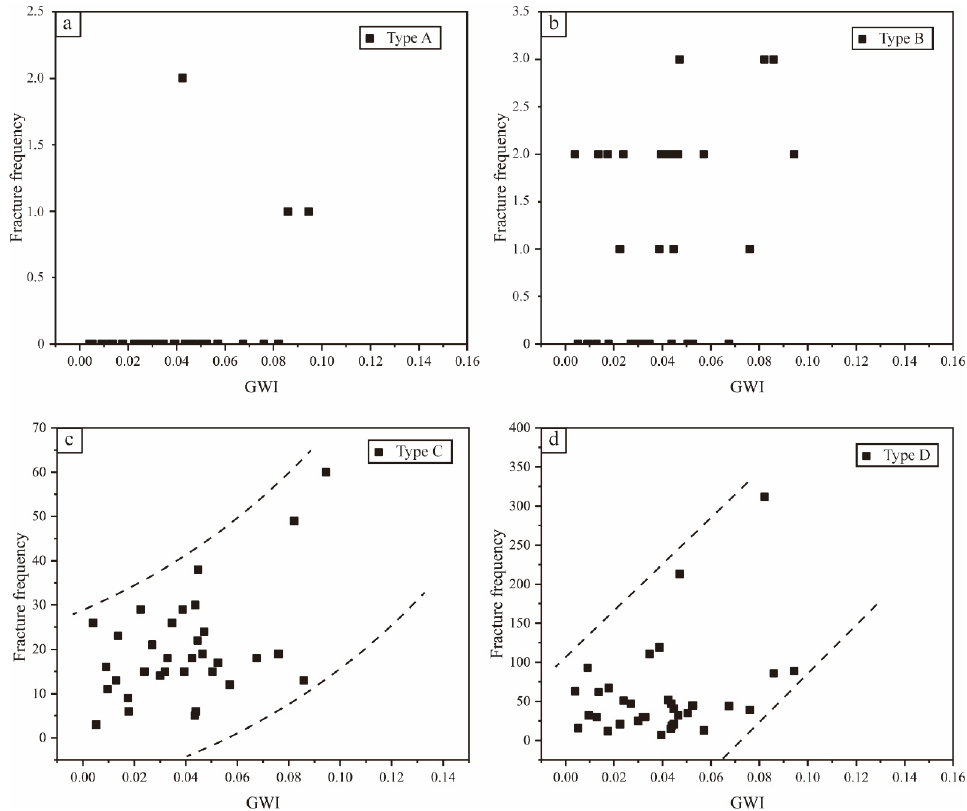
Figure 10. Relationships between the microfractures and coal facies index (GWI). ( a ) GWI against type A fractures; ( b ) GWI against type B fractures; ( c ) GWI against type C fractures; ( d ) GWI against